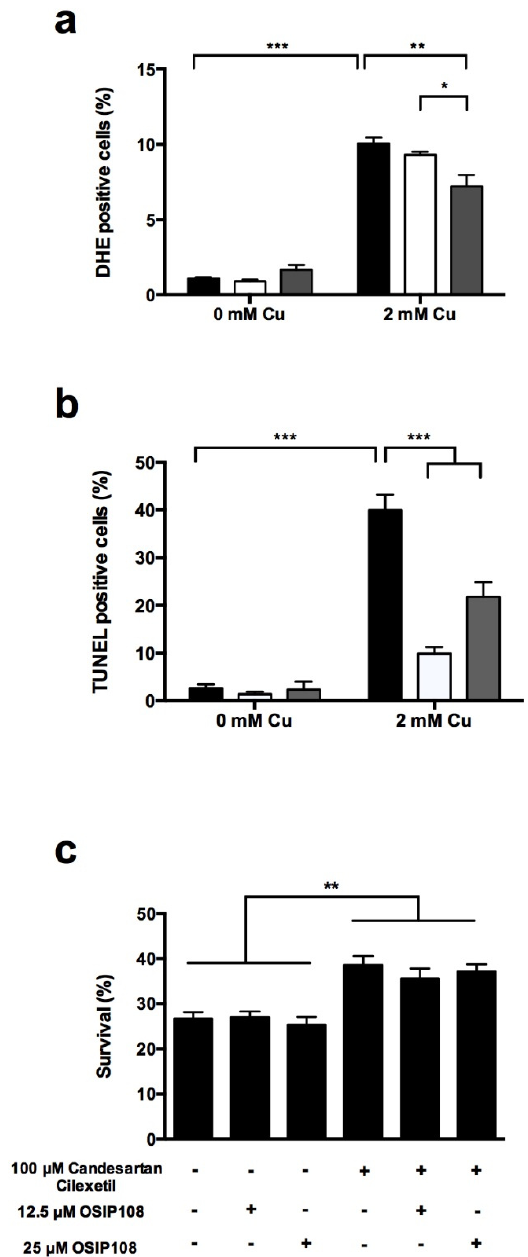
FIGURE: 2. ARBs reduce levels of Cu induced apoptotic markers in yeast. Yeast cells were incubated with 2 mM Cu for 4 h with control treatment (black bars), Losartan (white bars) or Candesar- tan Cilexetil (gray bars). Following treatment, cells were stained with DHE (a) or TUNEL assay (b) and subsequently analyzed by flow cytometry or counted manually after fluorescence microsco- py, respectively. Three biological repeats were used. (*P < 0.05; **P < 0.01; ***P < 0.001; ANOVA test using Tukey correction). (c) OSIP108 does not affect the rescue effect of Candesartan Cilexe- til. Yeast cells were incubated with 2 mM Cu for 4 h with control treatment, Candesartan Cilexetil (100 µM) in absence (2% DMSO) or presence of OSIP108 (12.5 µM – 25 µM). Following incubation, cells were plated on YPD agar plates and survival was calculated as compared to CFU/ml of cells receiving no Cu. Experiments per- formed in quadruplicate with three biological repeats. (*P < 0.05; **P < 0.01; ***P < 0.001; ANOVA test using Tukey